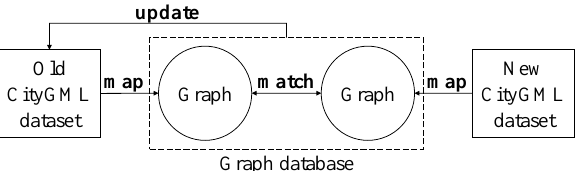
Figure 1. An overview of three major steps mapping, matching and updating of 3D city models using a graph database.